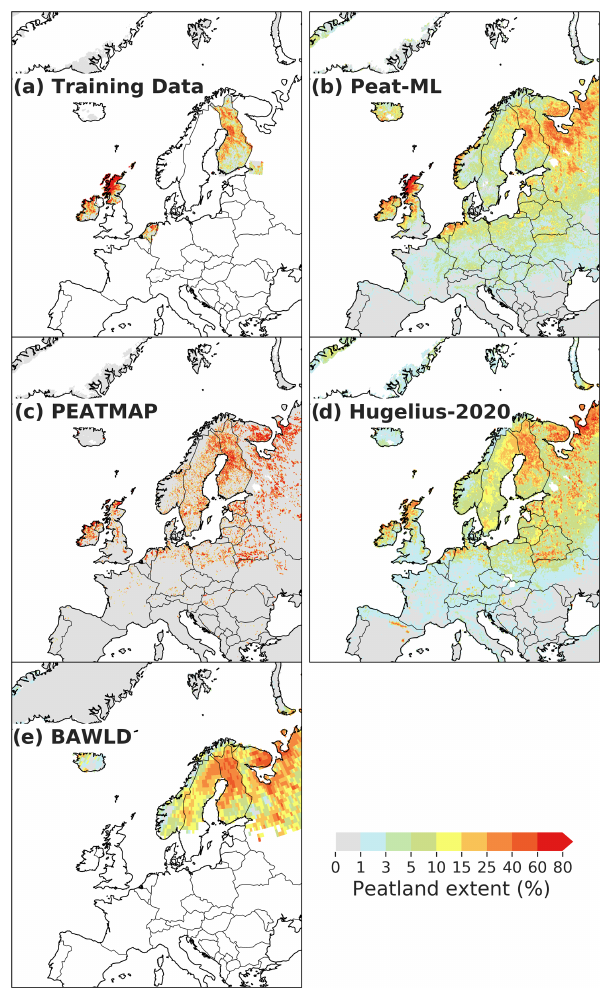
Figure A5. Maps of western European peatlands, including (a) training data used by the ML model; (b) Peat-ML-predicted peatlands; and the peatland coverage from (c) PEATMAP (Xu et al., 2018), (d) Hugelius et al. (2020), and (e) BAWLD (Olefeldt et al., 2021), whose domain only partly extends over the region